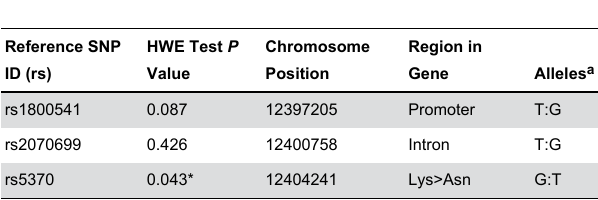
Table 3. Genotype and Allele Frequencies of Endothelin-1 SNPs among Pulmonary Metastatic Osteosarcoma Cases and